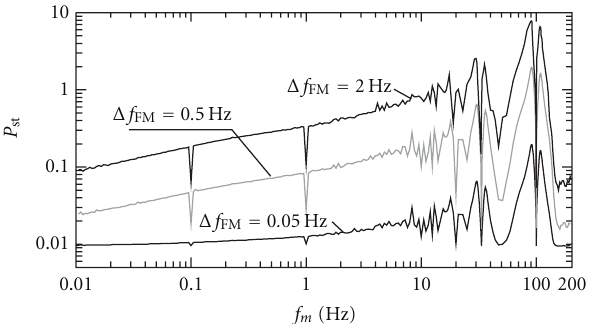
Figure 10: P st = f ( f m , Δ f FM ) characteristic for FM modulation with rectangular signals.